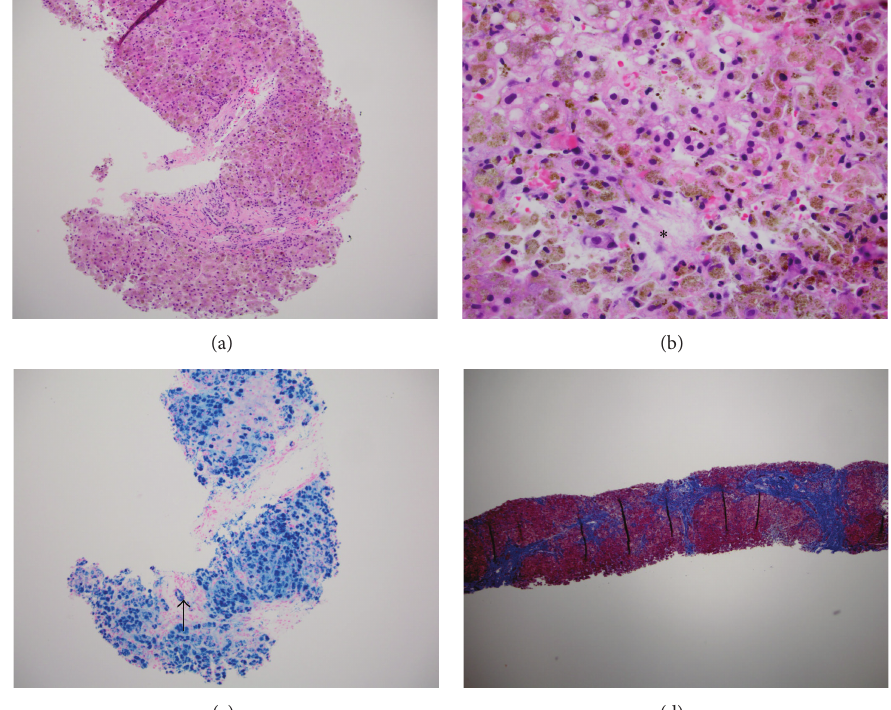
(d) Figure 1: Liver biopsy from a young woman with juvenile hemochromatosis due to mutations in HFE2 . (a) Iron appears as a brownish pigment in hepatocytes in this section stained with hematoxylin and eosin (10x magnification). (b) At higher power (40x magnification), the granular brown iron pigment is readily appreciated within hepatocytes. A small area of necrosis is indicated by the asterisk. (c) Perl’s Prussian Blue stain confirms 4+ iron in hepatocytes as well as heavy iron deposition in the epithelium of a bile duct (arrow; 10x magnification). (d) Trichrome stain highlights the nodular contour of the hepatic parenchyma outlined by thick bands of connective tissue (4x magnification).